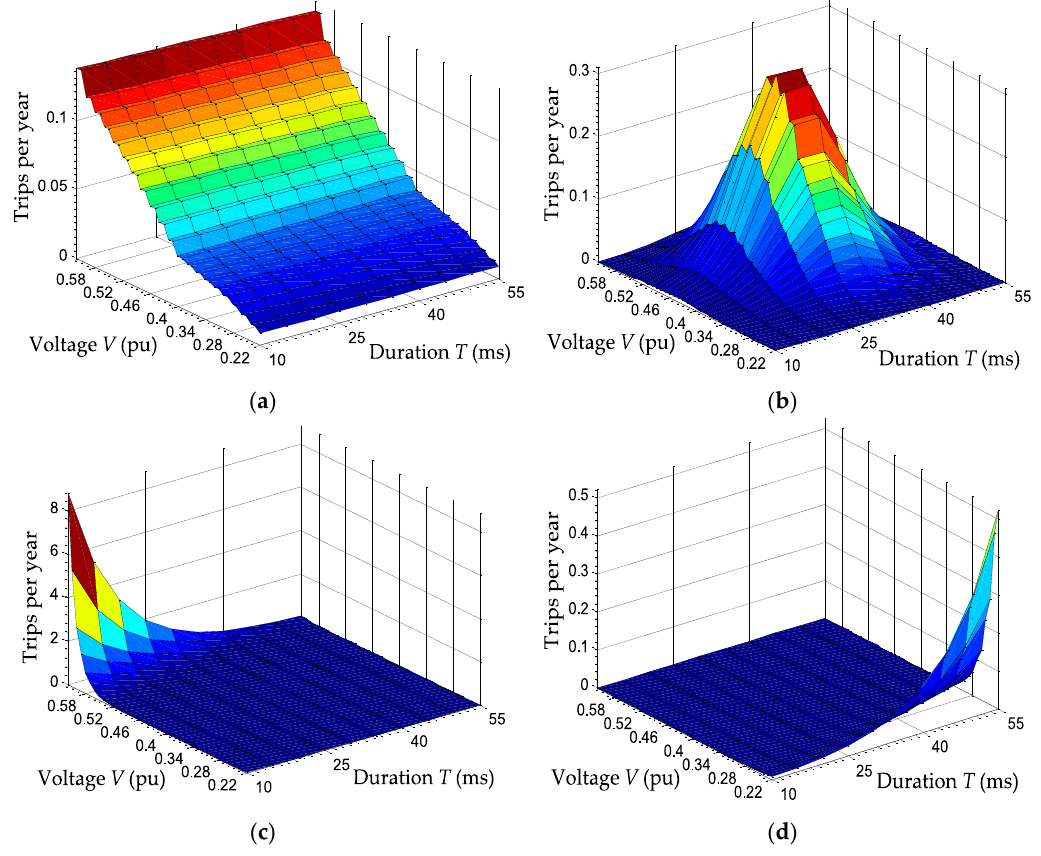
Figure 18. Number of expected trips per year of various voltage–tolerance characteristics for FL: ( a ) uniform; ( b ) normal; ( c ) exponential and ( d ) reverse exponential.